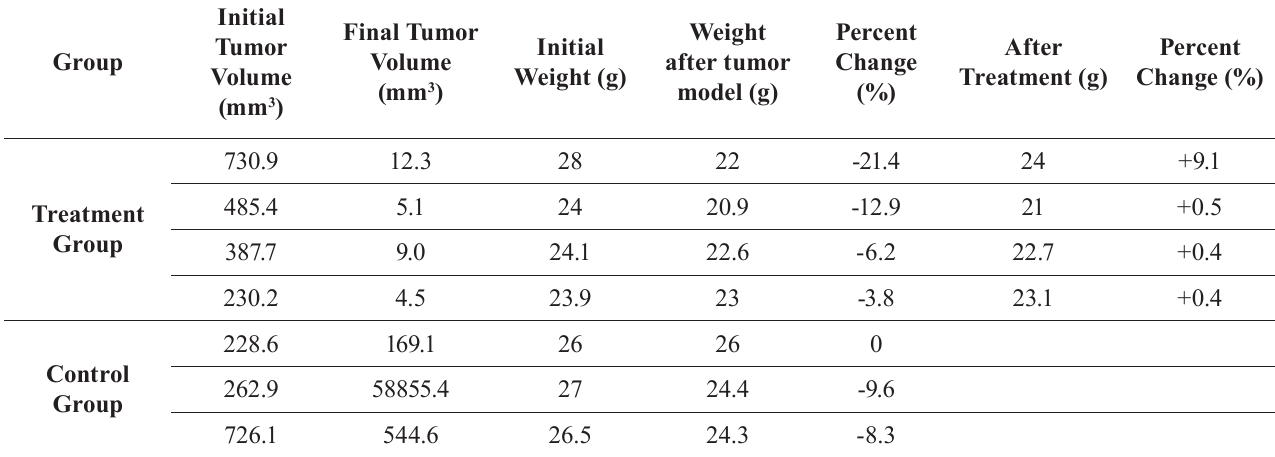
TABLE II - Tumor volume and weight alteration of treatment and control groups